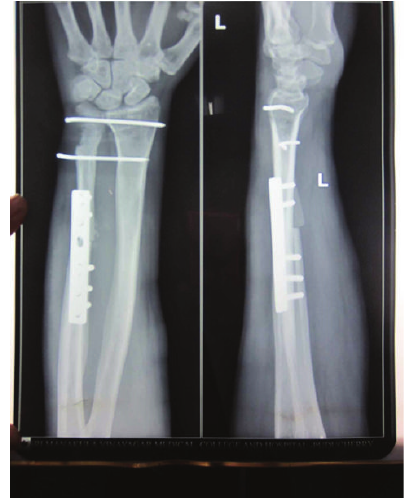
Figure 13: Immediate postoperative